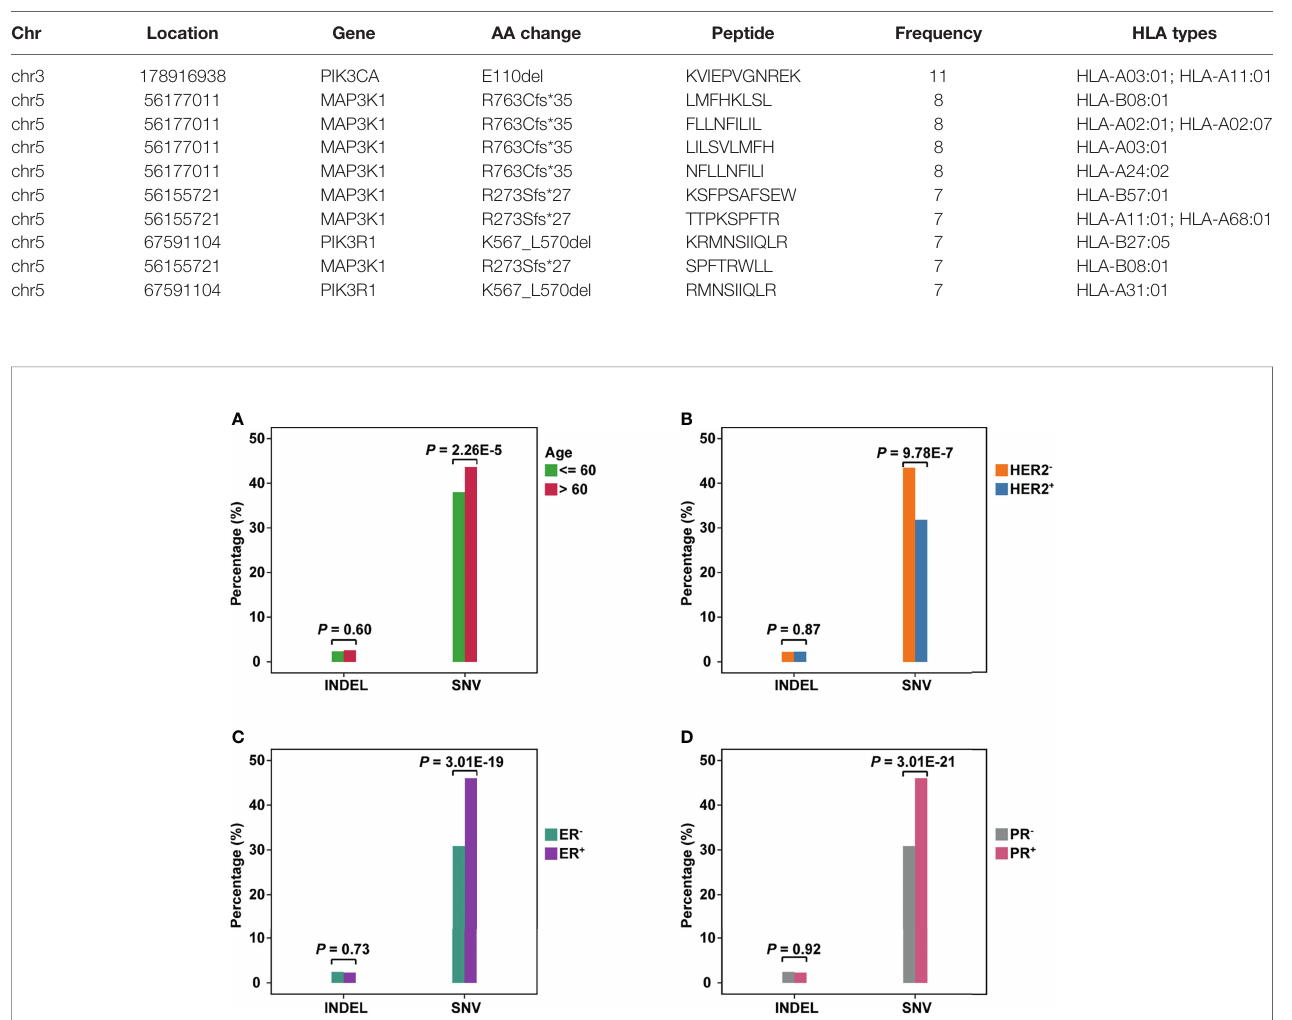
FIGURE 2 | The comparison of neoantigens between different subgroups of breast cancer. (A – D) The horizontal axis represents the neoantigens source, including INDELs and SNVs; the vertical axis represents the percentage of neoantigen-carrying patients in the corresponding subgroup. (A) : Group Age: <=60 vs > 60; (B) Group HER2 status: HER2 + vs HER2 - ; (C) Group ER status: ER + vs ER - ; (D) Group PR status: PR + vs PR - .